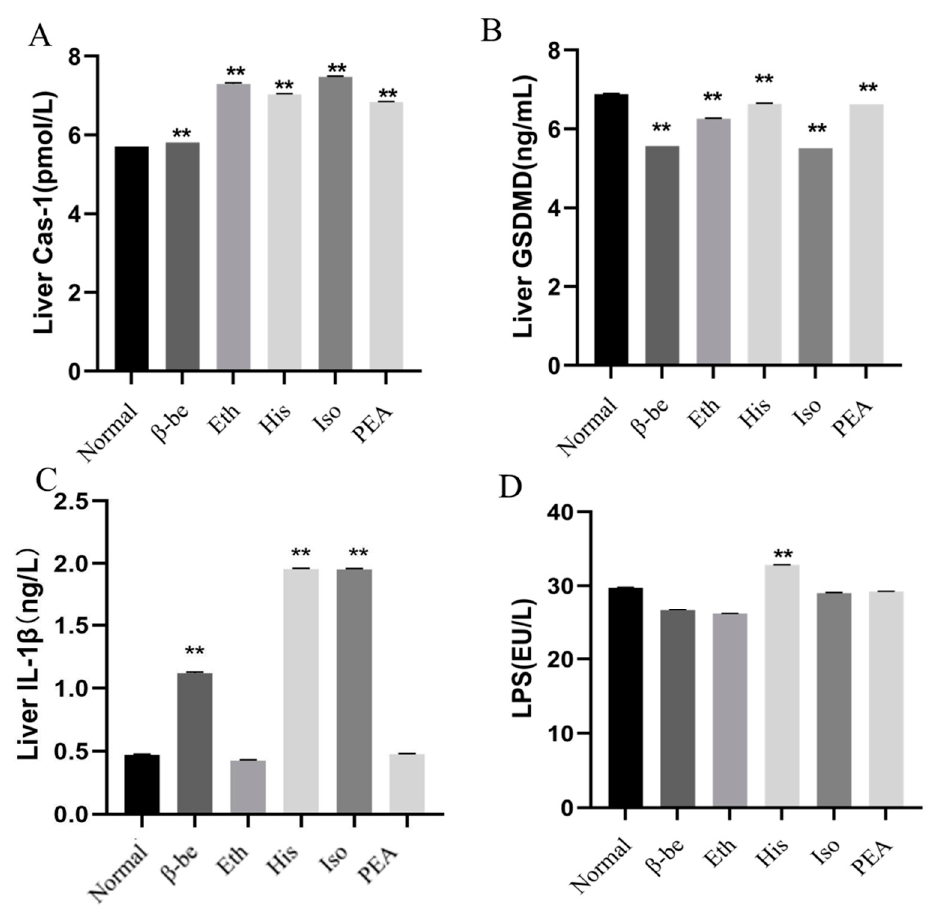
Figure 3 . The effects of His, PEA, β -be, and Iso on the pyroptosis pathway and LPS of the gut. ** p < 0.01. ( A ) Liver Cas-1. ( B ) Liver GSDMD. ( C ) Liver IL-1 β . ( D ) Gut LPS.